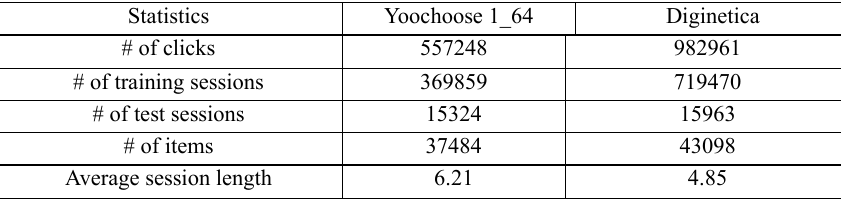
Table 1. Statistical information of the two datasets used in the